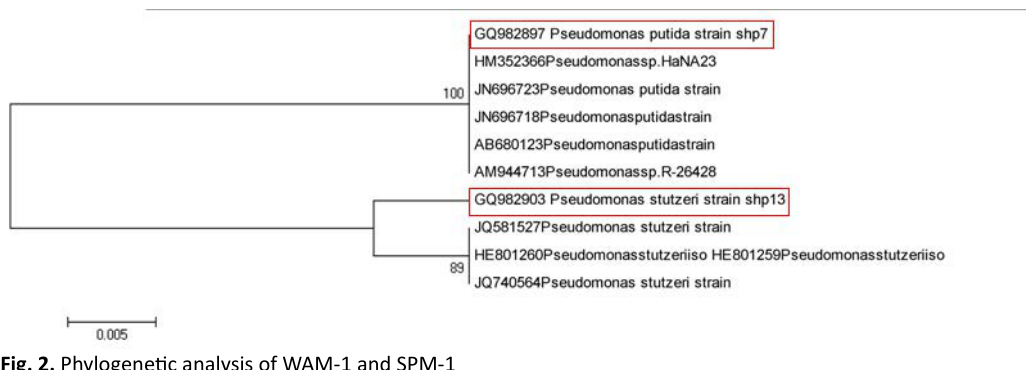
Fig. 2. Phylogenetic analysis of WAM-1 and